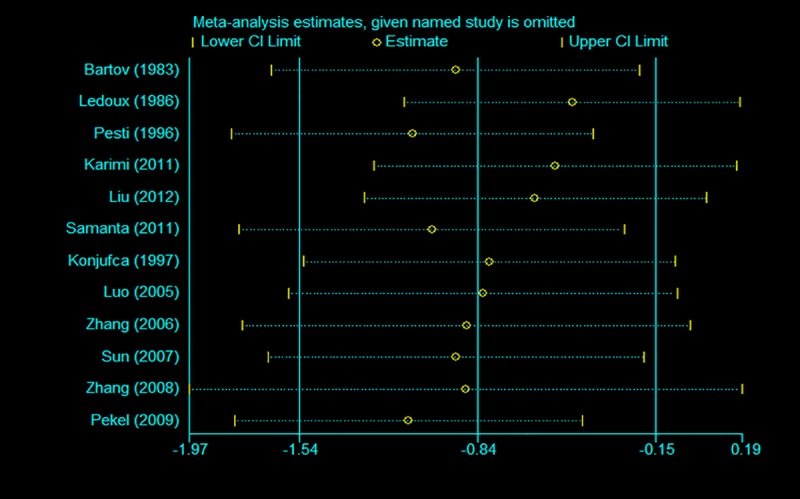
Sensitivity analysis of ADFI.